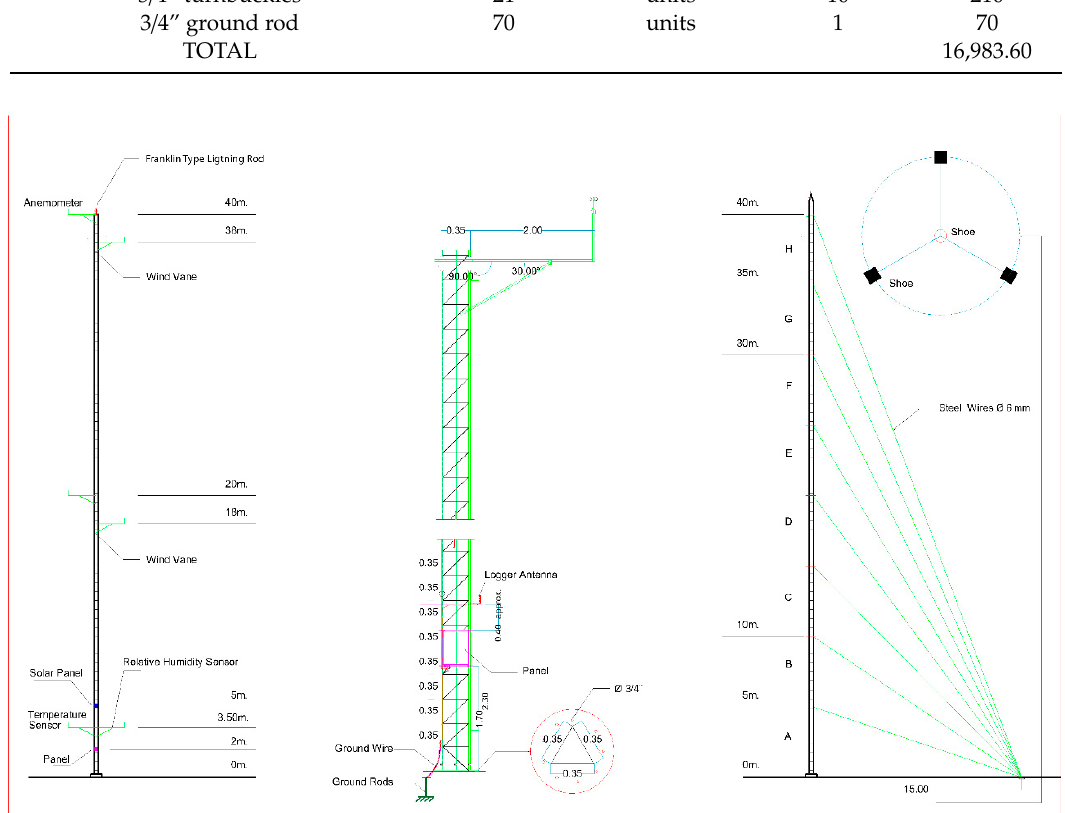
Figure 4. Details of design and assembly of the anemometer tower.